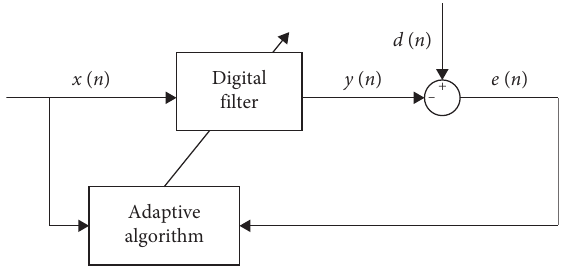
Figure 1: The schematic diagram of adaptive filtering where x ( n ) is the input signal of adaptive filter; y ( n ) and d ( n ) are the output signal and the desired signal of the filter; e ( n ) is the error algorithm based on the sigmoid function. By establishing the nonlinear relationship between the step size and error signal, which effectively compensated for the shortcomings in [10].